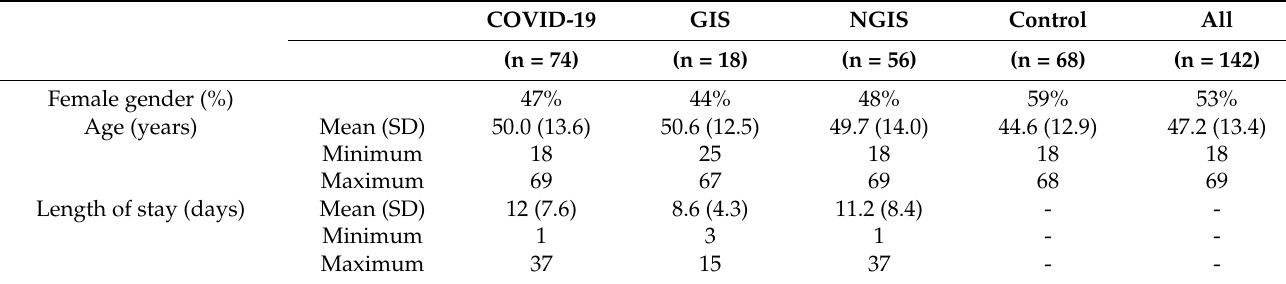
Table 1. Demographic